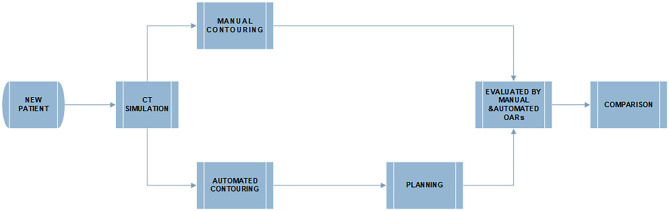
The flowchart of manual and deep learning automatic delineation-based plan evaluation experiment.